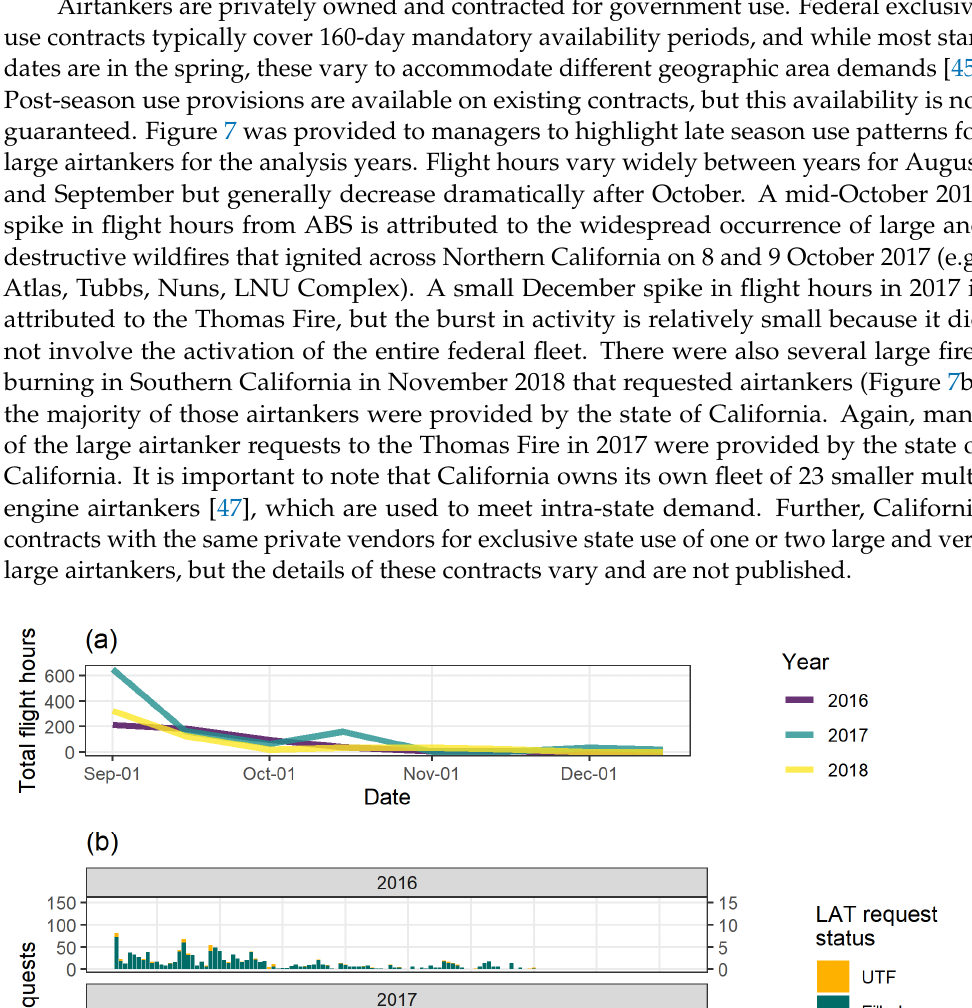
Figure 6. The daily number of structure (T1–T2) and wildland (T3–T7) engines assigned to wildland fires in the United States between 1 October and 31 December in 2016, 2017, and